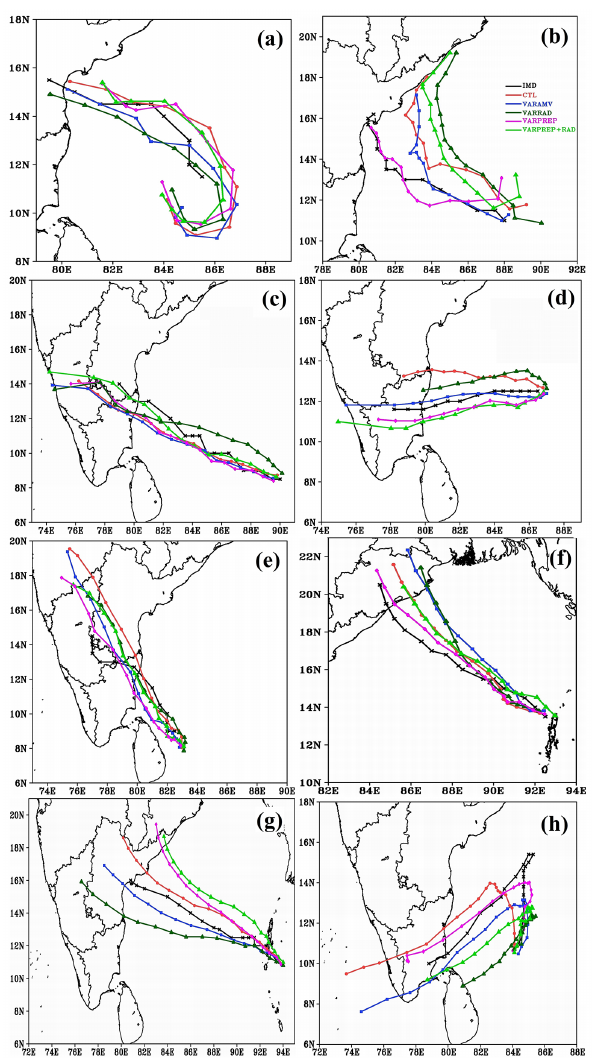
Figure 15. Simulated vector track positions along with IMD best track from CTL and 3D-Var experiments for eight tropical cyclones over the BOB (a) Khaimuk, (b) Laila, (c) Jal, (d) Thane, (e) Nilam, (f) Phailin, (g) Lehar and (h) Madi.